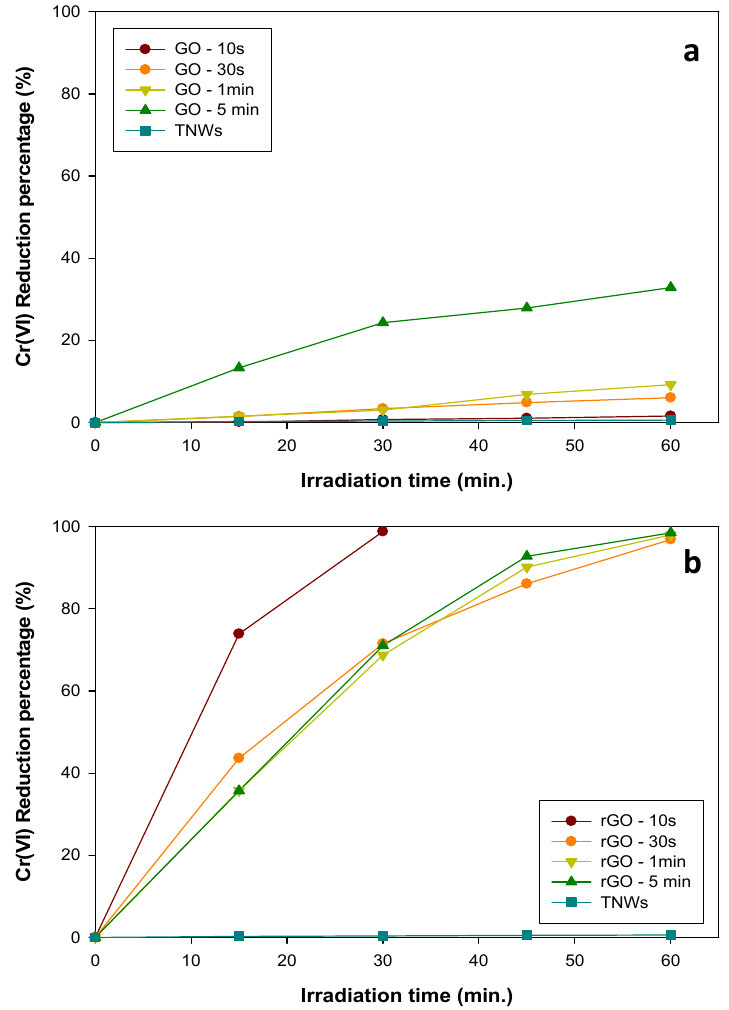
Figure 6. Photocatalytic reduction of Cr(VI) illuminated under visible light using different samples: ( a ) TNW and GO/TNW samples; and ( b ) TNW and rGO/TNW samples. The PL spectra of TNW, GO/TNW, and rGO/TNW samples are shown in Figure 7. The clear PL peak centered at 570 nm may be related to defects that are recombination centers of the photogenerated electron-hole pairs. Some examples are oxygen vacancies, the K 2 Ti 6 O 13 phase, and interstitial defects within the TiO 2 lattice [40–42]. Recombination is obvious for the TNW sample but not for the GO/TNWs and very much reduced for the rGO/TNW sample. This is possibly the result of the rapid transfer of electrons from GO or rGO suppressing recombination [43,44]. With more free electrons available and higher mobility of electrons in rGO, a more rapid reduction process leads to a fast and complete removal of Cr(VI) within 30 min of exposure to visible light. Furthermore, the improved photoreduction performance of the rGO/TNWs compared to TNWs is attributed to the great enhancement of electron transport through the rGO in the rGO/TNW sample and its consequent charge separation.